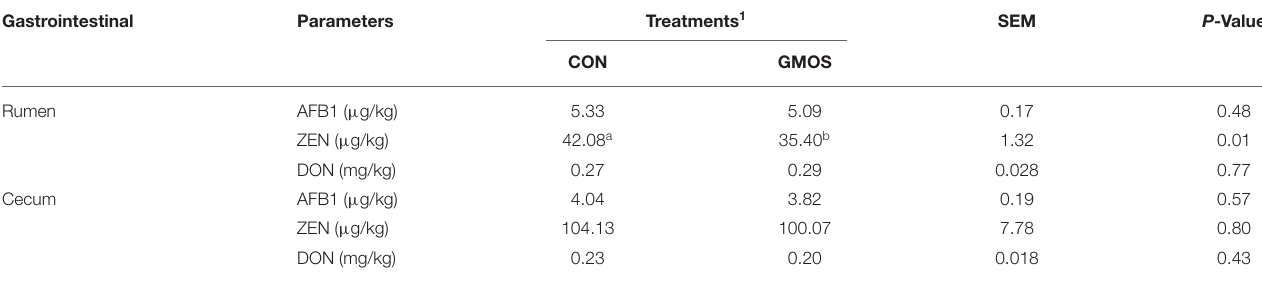
TABLE 3 | Effects of dietary supplementation of GMOS on concentrations of toxins in the gastrointestinal digesta in goats.